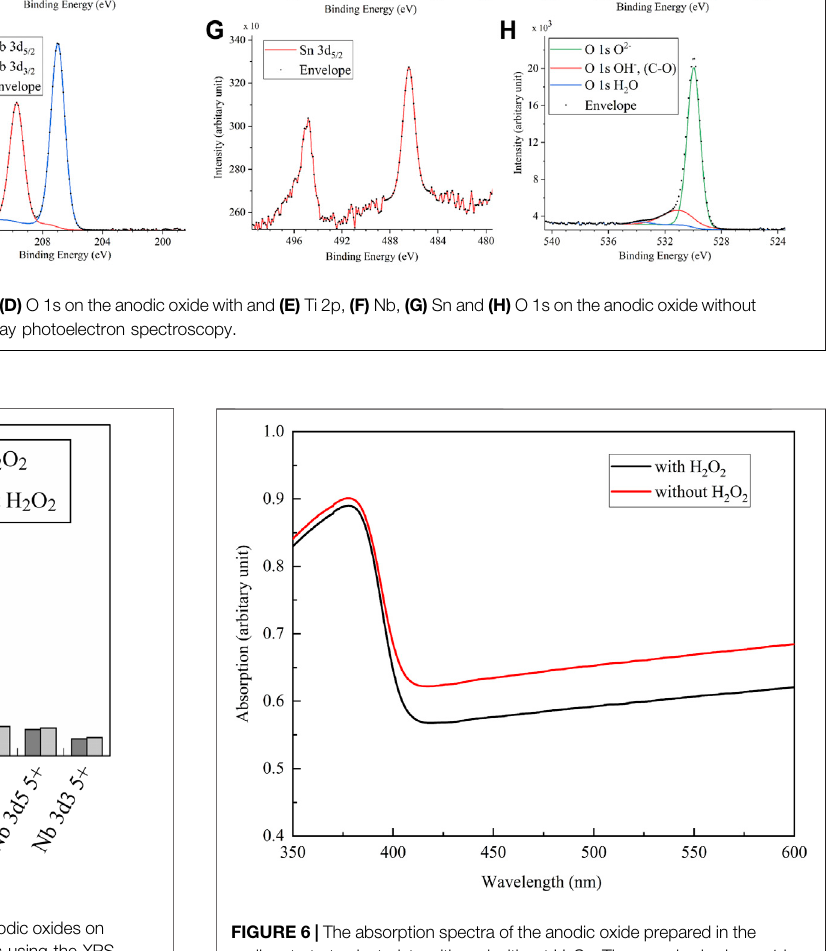
FIGURE 6 | The absorption spectra of the anodic oxide prepared in the sodium tartrate electrolyte with and without H 2 O 2 . The sample size is n = 1 in each